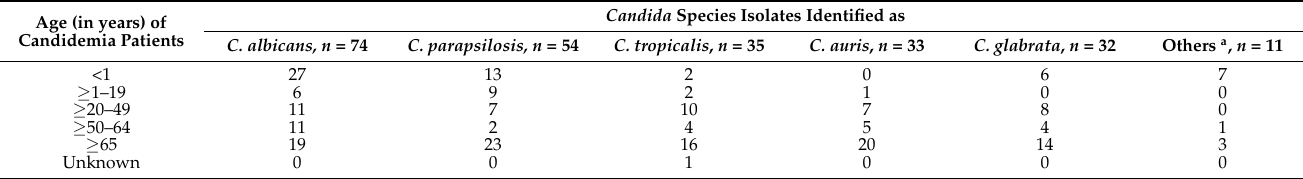
Candida Species Isolates Identified